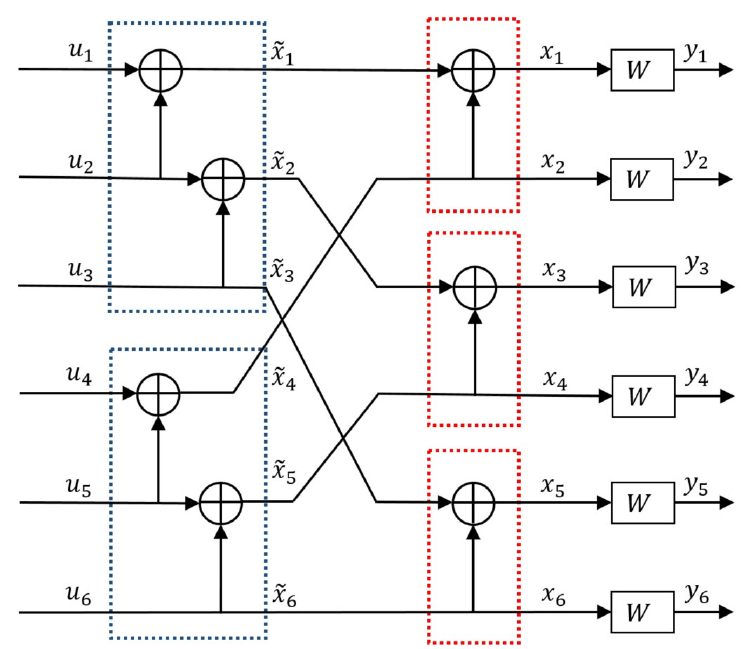
Figure 2. Version B of the 6 × 6 circuit for channel